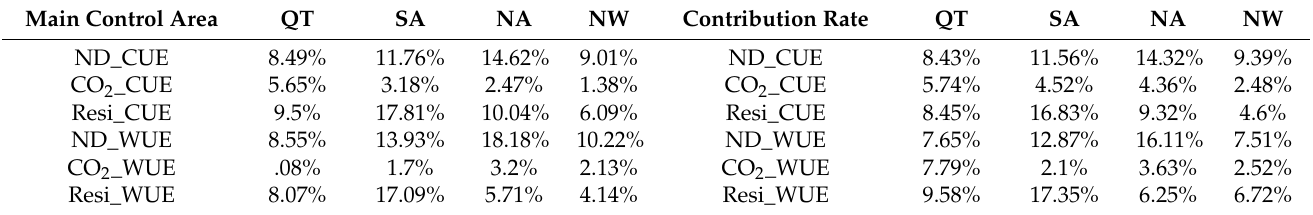
Figure 6. ND and CO 2 and residual factors for the main control area of CUE and WUE. ( a ) ND and CO 2 and residual factors for the main control area of CUE, ( b ) ND and CO 2 and residual factors for the main control area of WUE.